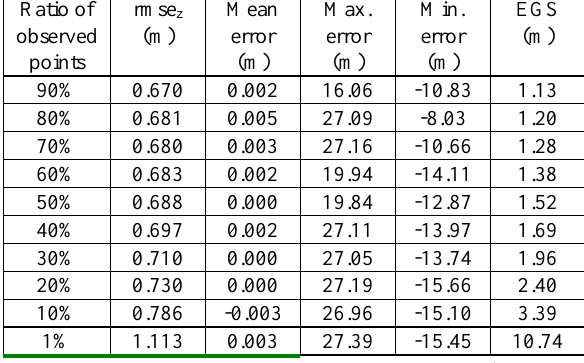
Table 3. Vertical accuracy of TLI-computed DSMs (1 m grid spacing) depending on the ratio of observed points relative to the total. EGS = Equivalent Grid Spacing